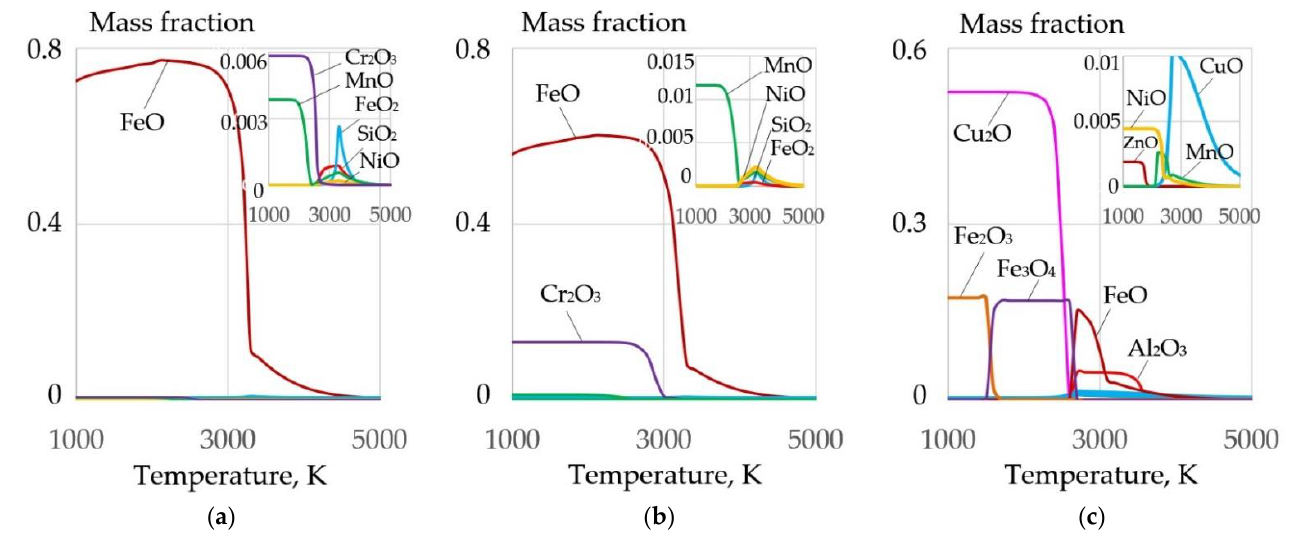
Figure 15. Mass fractions of oxides in the equilibrium system, wt.%: ( a ) 25FeCO 3 -25KNO 3 -50(10KhSND) steel; ( b ) 25FeCO 3 - 25KNO 3 -50(AISI 304L) steel; ( c ) 25FeCO 3 -25KNO 3 -50(CuAl5) alloy.